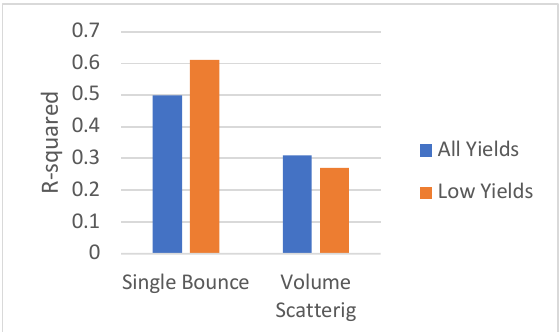
Figure 4. Correlation of determination between the SAR features and soybean yield.